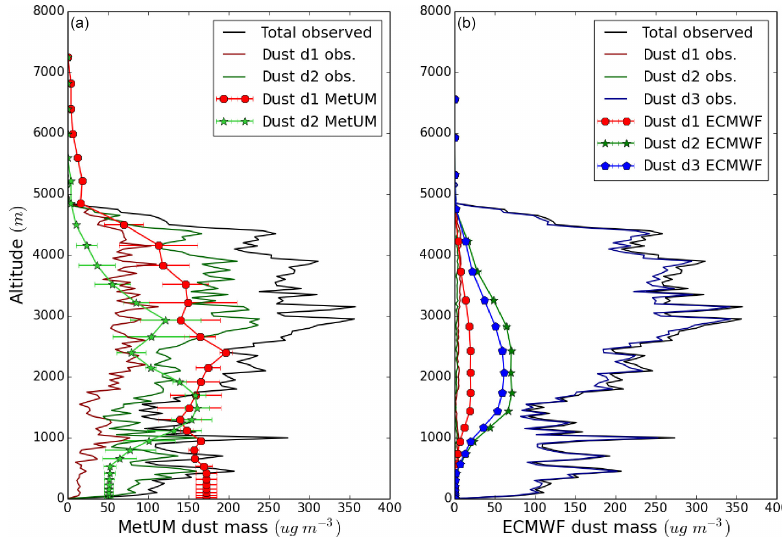
Figure 6. Case study 1, B920, 7 August, P2. (a) Dust concentration measured by the in situ instruments on the aircraft for MetUM dust divisions 1 (red) and 2 (green), as well as the total dust concentration measured (black). The division 1 and 2 concentration from the model is shown in a lighter shade of red and green, respectively, with markers and error bars showing the standard deviation. (b) The right-hand plot shows the same thing but for the ECMWF–CAMS size bins, with the measurements shown using lines and the model values with lines and markers for divisions 1 (red), 2 (green), and 3 (blue).